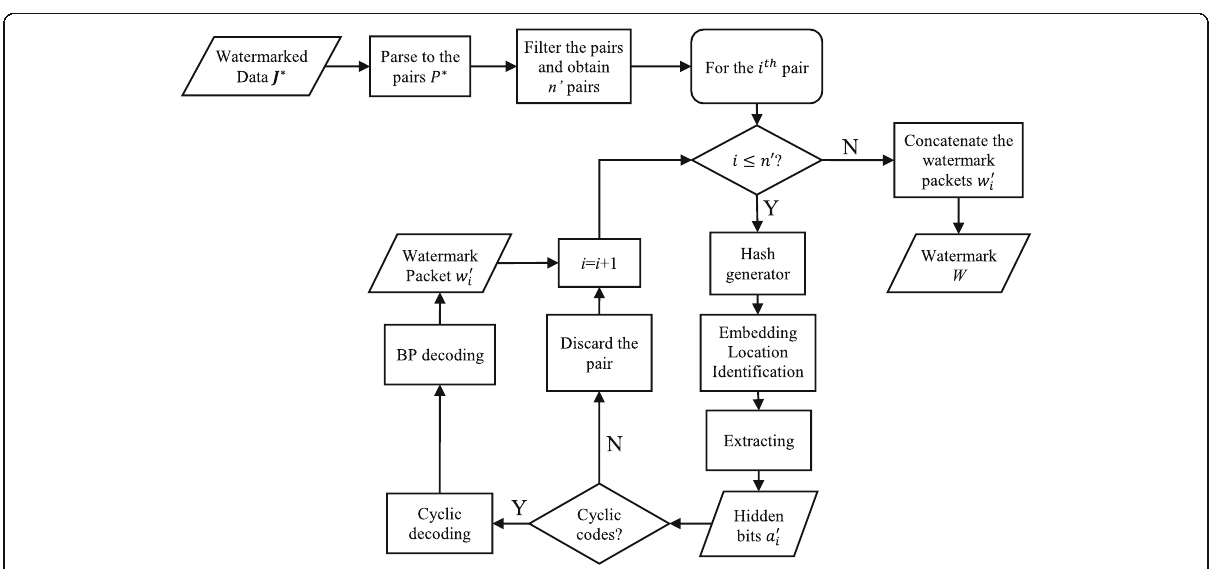
Fig. 5 Flowchart of watermark